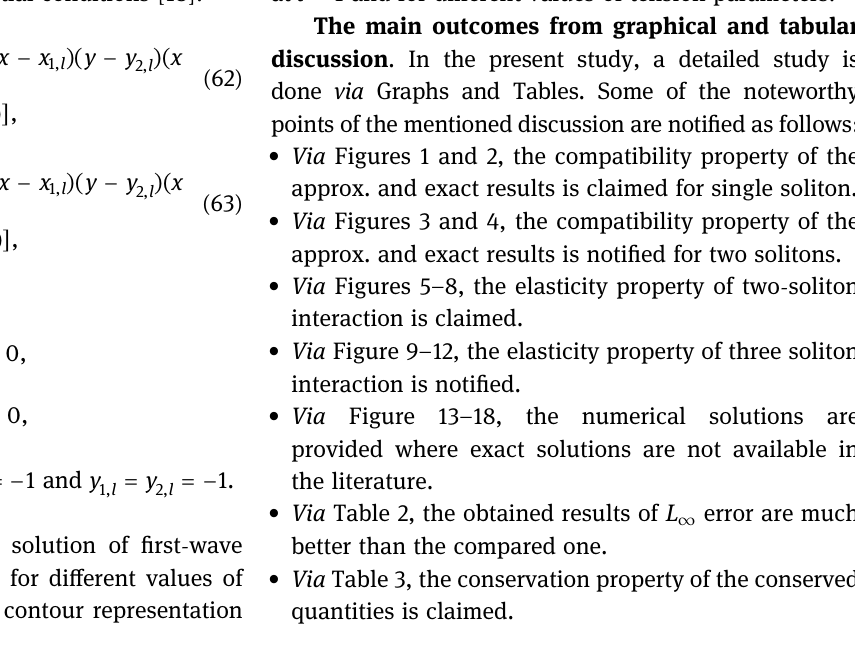
Figure 18: Graphical representation of numerical solution of second - wave amplitude at = t 1 for parameters = N 21 , = t Δ 0.0001 , = α 0.1 and for di ff erent values of tension parameter τ of numerical solution of second - wave amplitude is given at t 1 = and for di ff erent values of tension parameters.